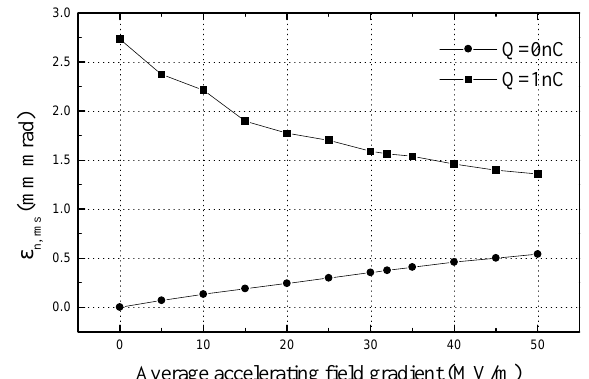
FIG. 10. Emittance growth in the PWT linac structure with accelerating field gradient for different pulse